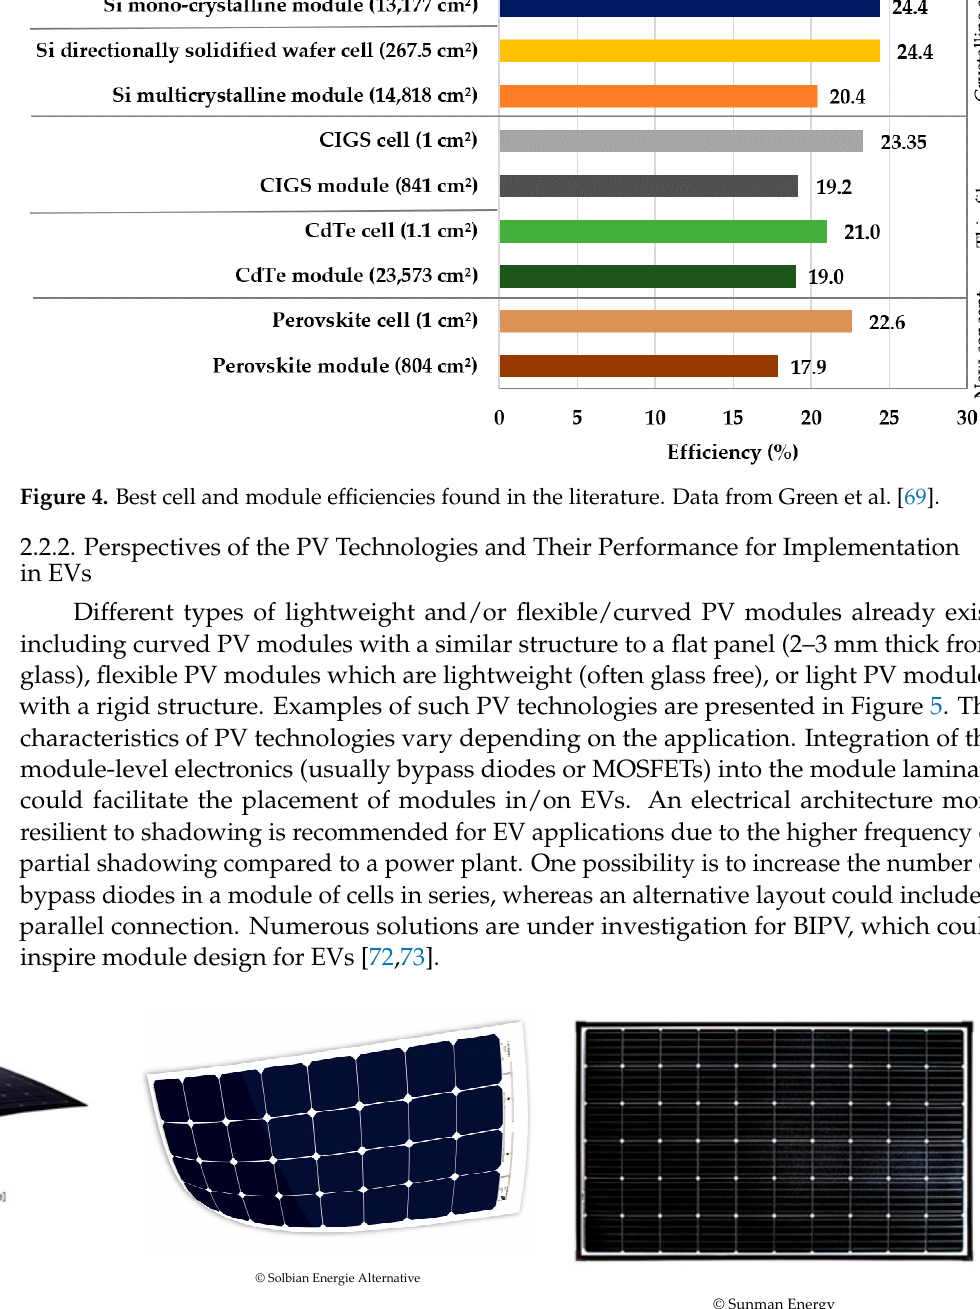
Table 2. Non-comprehensive chart of light rigid and/or flexible PV technologies and their performances. Manufactu Type rer